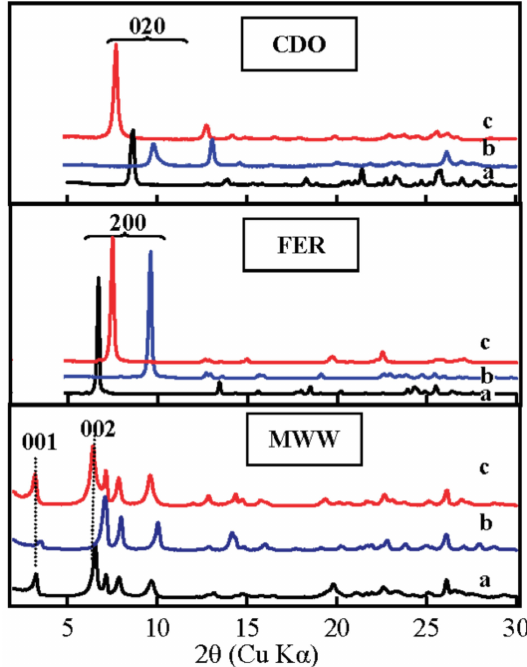
Figure 2. XRD patterns of ( a ) lamellar precursors, ( b ) 3D zeolites formed by the direct calcination of precursors, and ( c ) IEZs samples after further calcination. Reprinted with permission from ref. [36]. Copyright 2008, American Chemical